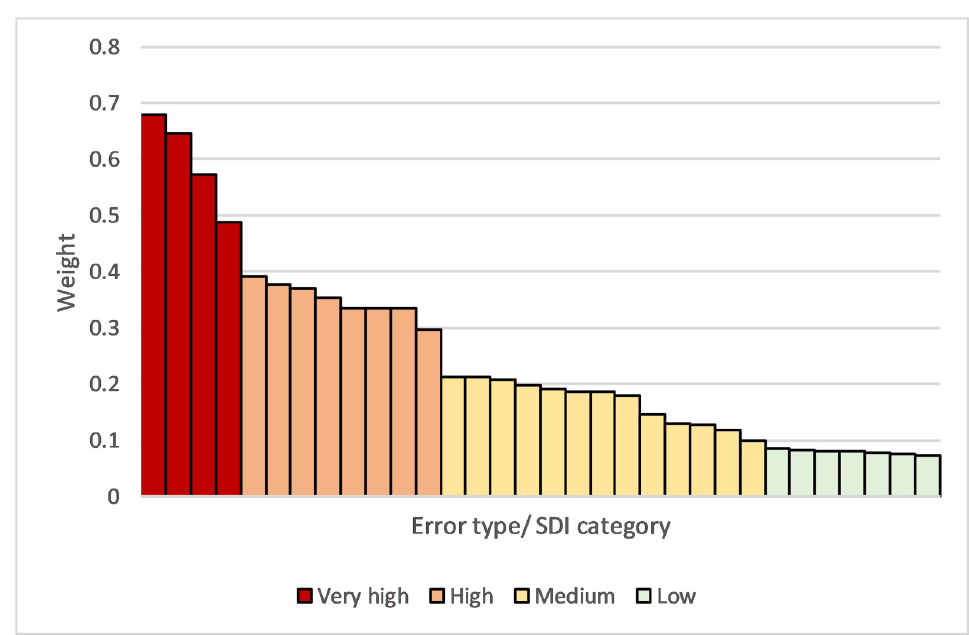
Fig 1. Error weights of each error type and SDI category. Very high impact (Red): Weight > 0.40. High impact (Orange): Weight 0.25 < 0.40. Medium impact (Yellow): Weight 0.10 < 0.25. Low impact (Green): Weight < 0.10.